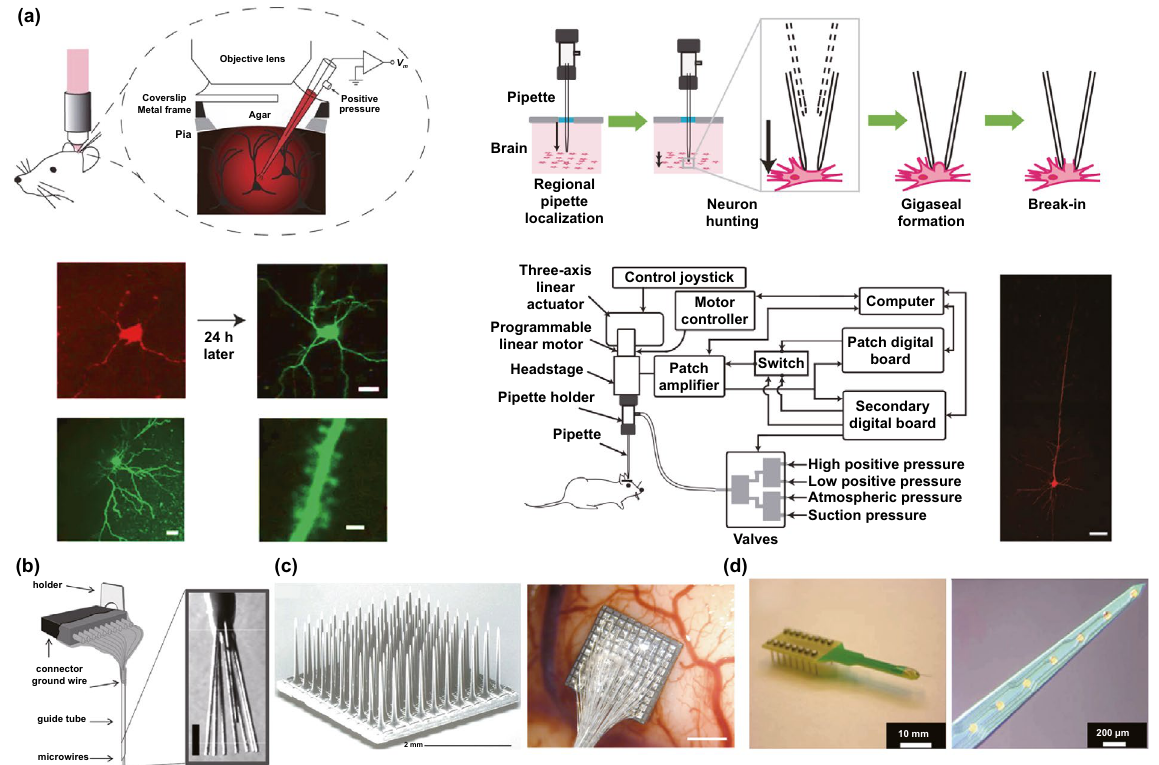
Fig. 16 Versatile brain electrodes for neuroscience study. a In vivo patch‑clamp and automatic patch‑clamp for neuronal action potential record‑ ing and plasmid DNA delivery electroporation [261, 262]. b Traditional microwires and stacked microwires [267]. c 100 microelectrodes of Utah electrode array [268]. d Single‑shank and multiple‑shank Michigan electrode array [269]. Reproduced with permission from Refs. [261, 262, 267–269], copyright (2008) Nature Publishing Group, (2012) Nature Publishing Group, (2011) Elsevier B.V. Publishing Group,